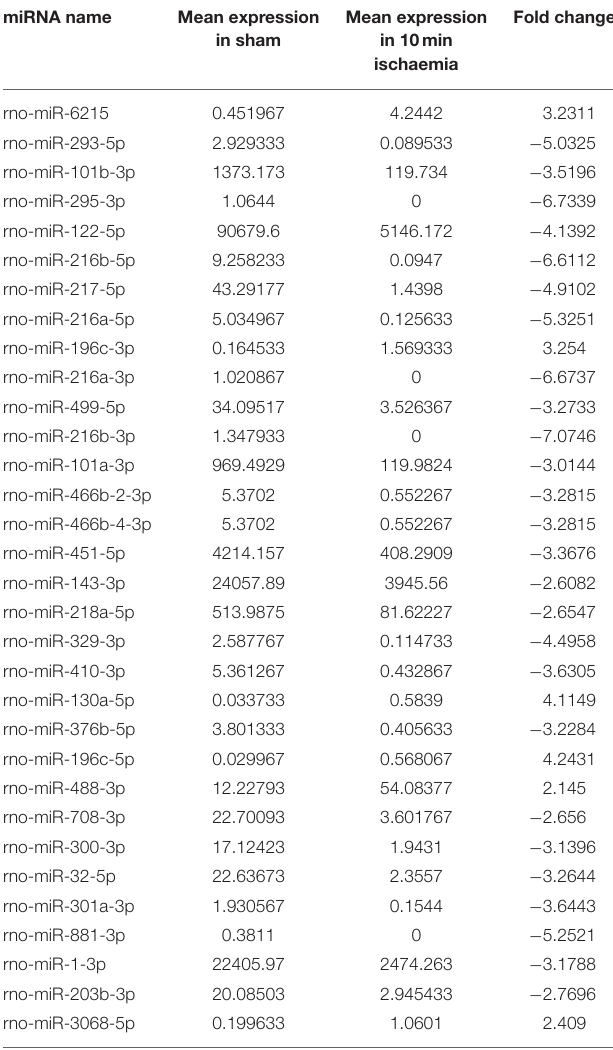
TABLE 2 | Plasma miRNAs differentially expressed between sham controls and 10min ischaemia rats ( P <